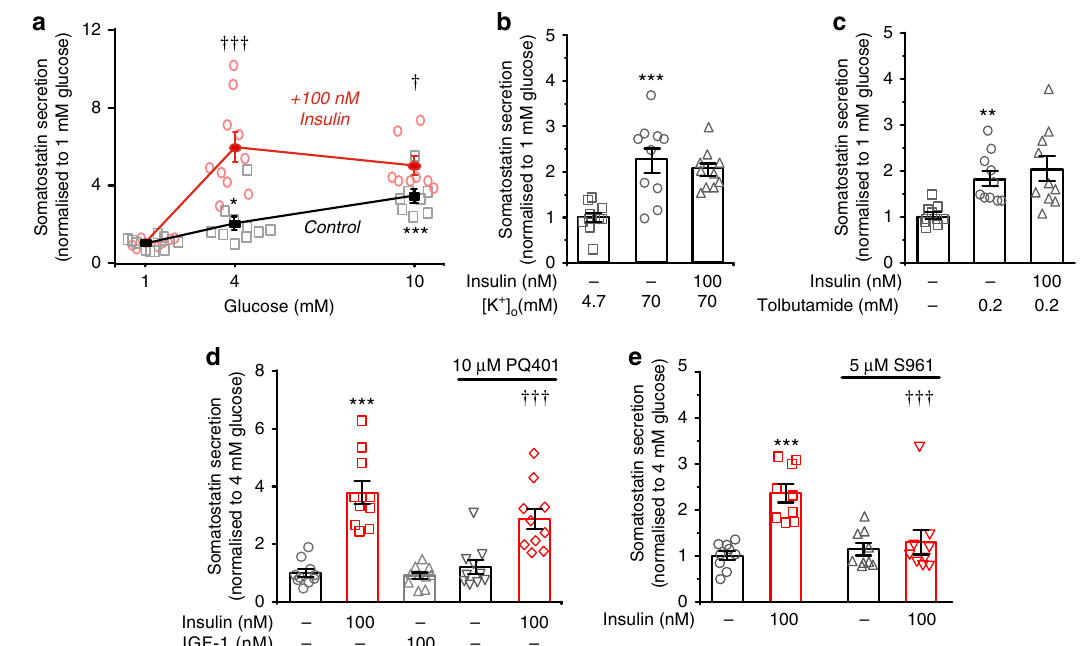
Fig. 1 Insulin stimulates somatostatin secretion. a Somatostatin release at 1, 4 and 10 mM glucose in the absence or presence of 100 nM insulin ( n = 8 – 10 experiments using six male mice). † p < 0.05, ††† p < 0.001 vs the same glucose concentration but in the absence of insulin, one-way ANOVA followed by Dunnet ’ s post hoc test. Glucose (4 and 20 mM) also stimulates somatostatin secretion compared with 1 mM in both the absence and presence of insulin ( p < 0.05 or better, not indicated for clarity). b , c Lack of effect of insulin on somatostatin secretion elicited by high [K + ] o (70 mM at 4 mM glucose; b ) and by the K ATP channel blocker tolbutamide (0.2 mM at 1 mM glucose; c ). When [K + ] o was increased, Na + was correspondingly reduced to maintain iso- osmolarity. ** p < 0.01 vs 1 mM glucose alone ( n = 10 experiments/5 male mice), one-way ANOVA followed by Dunnet ’ s post hoc test. d Effects of insulin or IGF-1 on somatostatin secretion at 4 mM glucose in the absence and presence of the IGF-1R inhibitor PQ401 ( n = 10 experiments using six male mice). *** p < 0.001 vs control (no insulin); ††† p < 0.001 vs control in the presence of PQ401, one-way ANOVA followed by Dunnet ’ s post hoc test. e Effects of insulin and the insulin receptor antagonist S961 on somatostatin release in isolated mouse islets incubated at 4 mM glucose ( n = 9 experiments/3 male mice). *** p < 0.001 vs no insulin. ††† p < 0.001 vs 100 nM insulin in the absence of S961, one-way ANOVA followed by Dunnet ’ s post hoc test. Responses have been normalised to somatostatin secretion at 1 mM or 4 mM glucose as indicated. Data are presented as dot plots of individual experiments and/or mean values ± S.E.M. of all experiments with the experimental